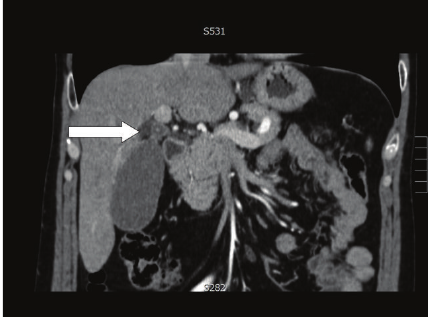
Figure 3: Level of obstruction (personal